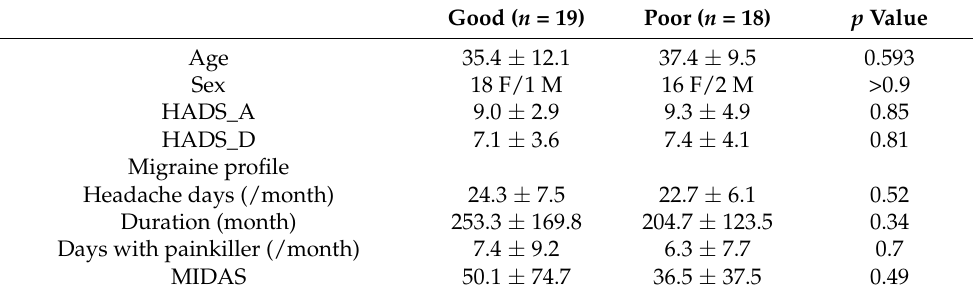
Table 3. Demographics, psychological characteristics and headache profiles in CMs with different treatment outcomes.